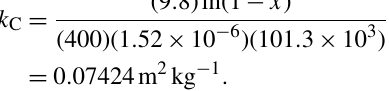
Figure A2. Variation of evapotranspiration/convection with surface temperature. The hyperbolic function is tangent to the horizontal as the temperature decreases, and grows almost linearly with a slope of about 6 as temperature